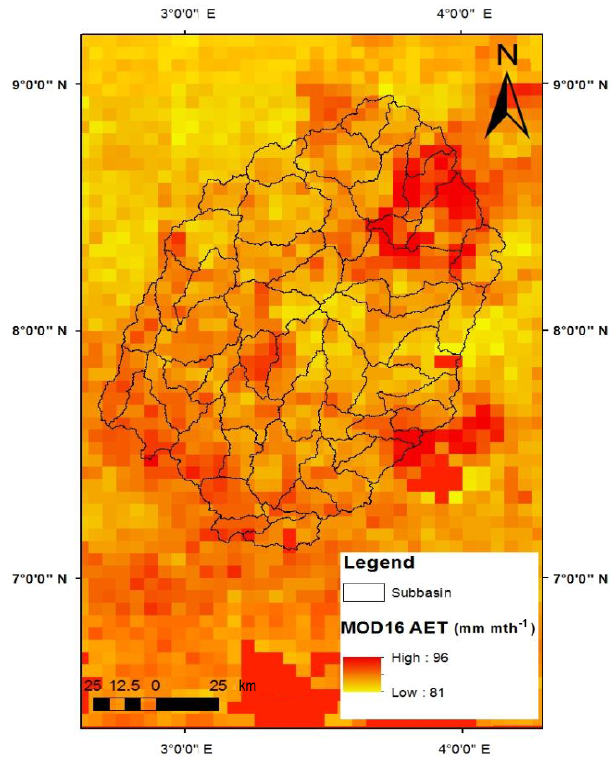
Figure D2. Mean monthly actual evapotranspiration of MOD16 over the entire Ogun River Basin for